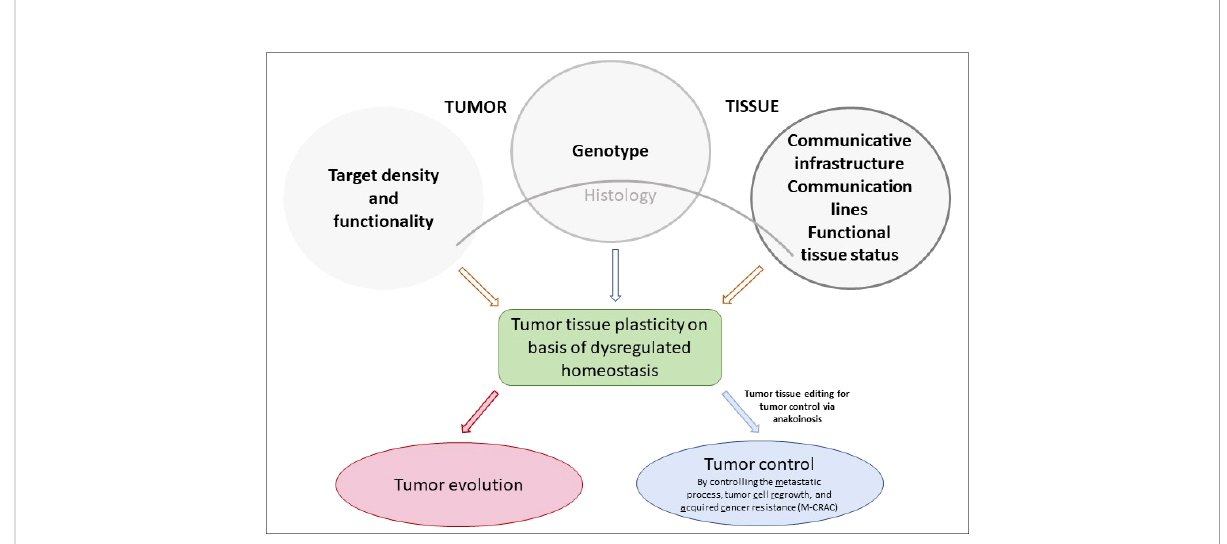
FIGURE 1 Genotype, target density and functionality, communicative infrastructure and functional status of tumor tissues determine tumor tissues ’ plasticity via dysregulated homeostatic pathways that are the targets for pro-anakoinotic, concerted biomodulatory therapy approaches, designed for stopping tumor growth or for inducing continuous complete remission in the best case, just in refractory or relapsed